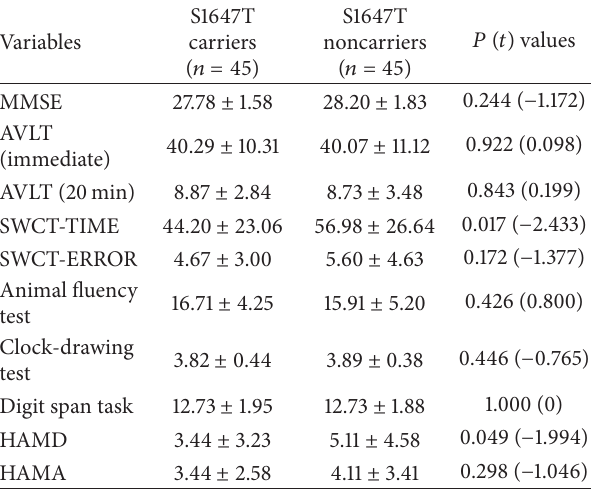
Table 2: Cognitive assessment of S1647T carriers and noncarriers with PD.